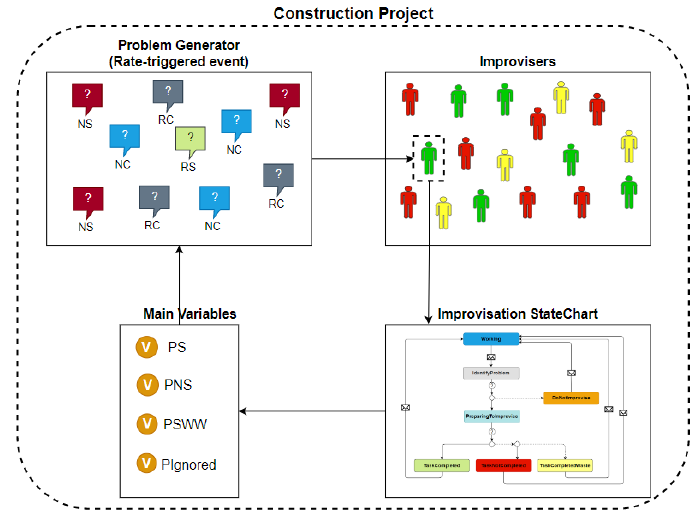
Figure 4. Flow of the model.